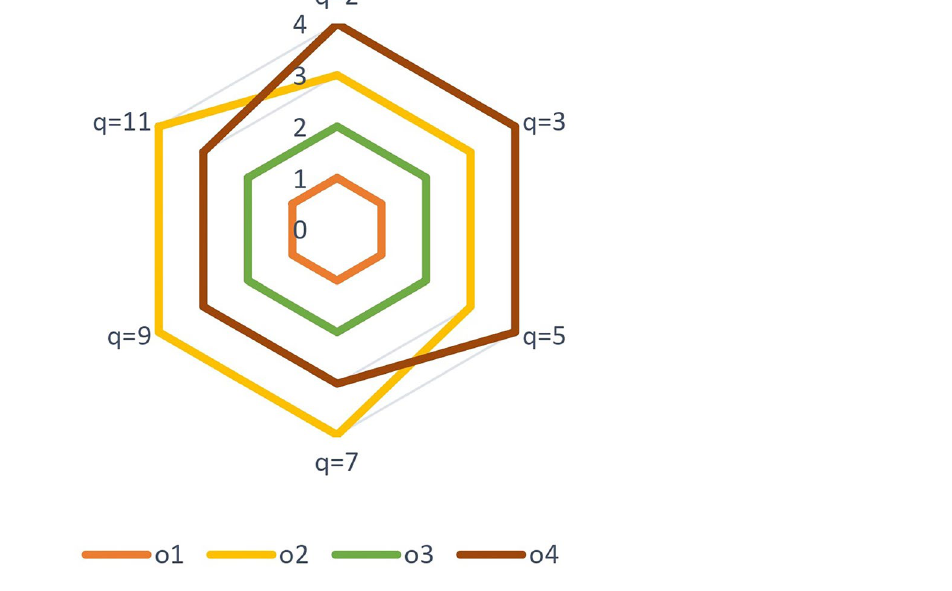
Figure 3. Sensitivity analysis with respect to q .